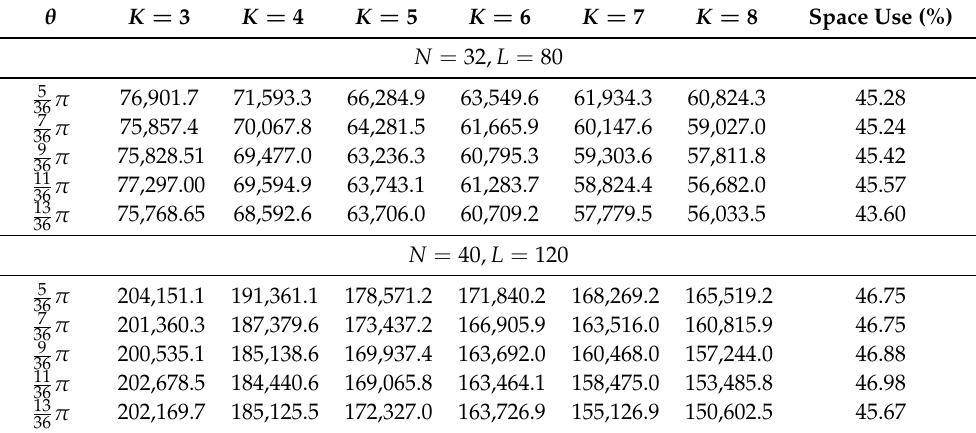
Table 11. The influence of aisle angle on distance and space